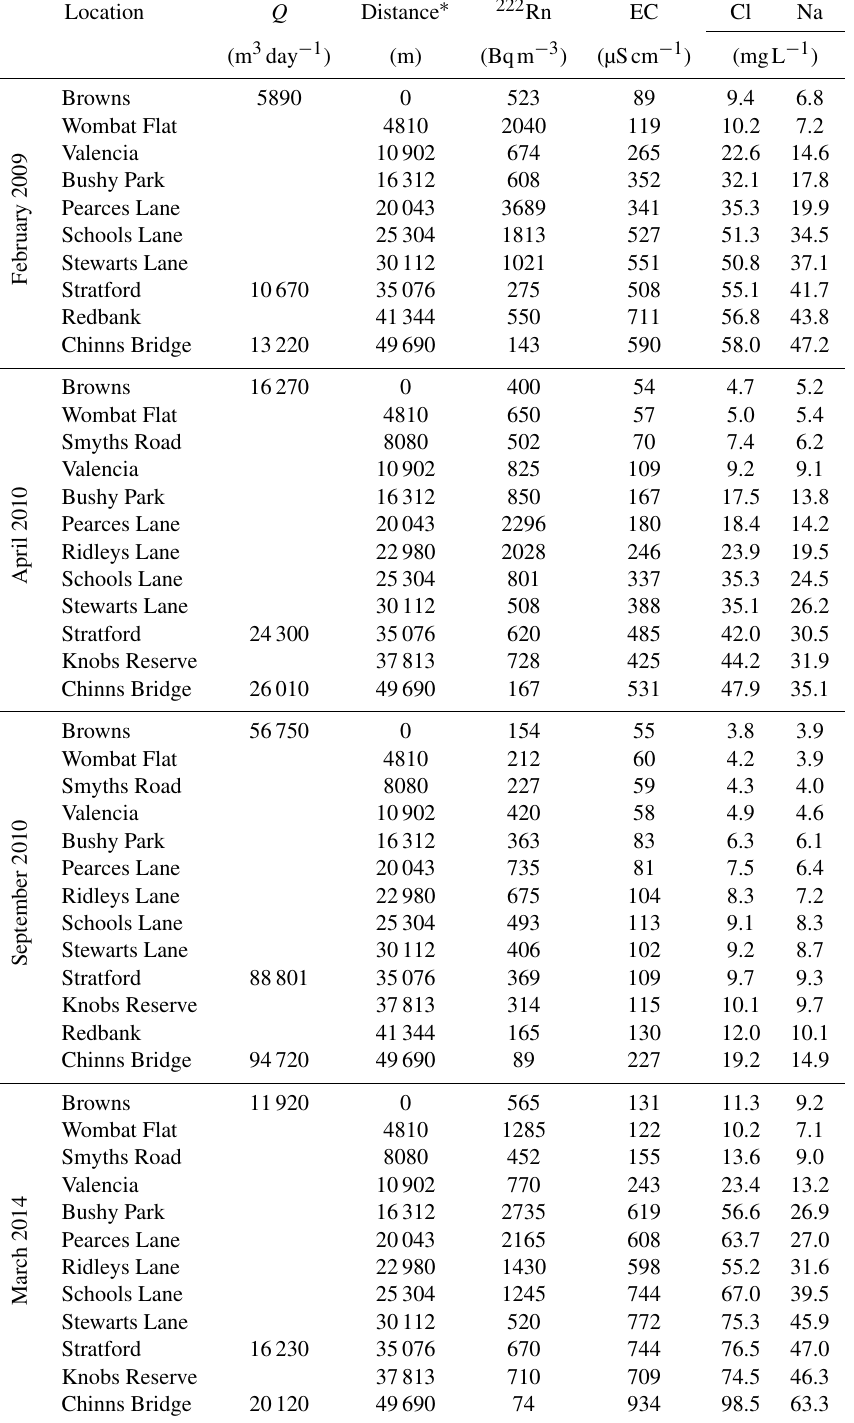
Table A1. Discharge and geochemistry of the Avon